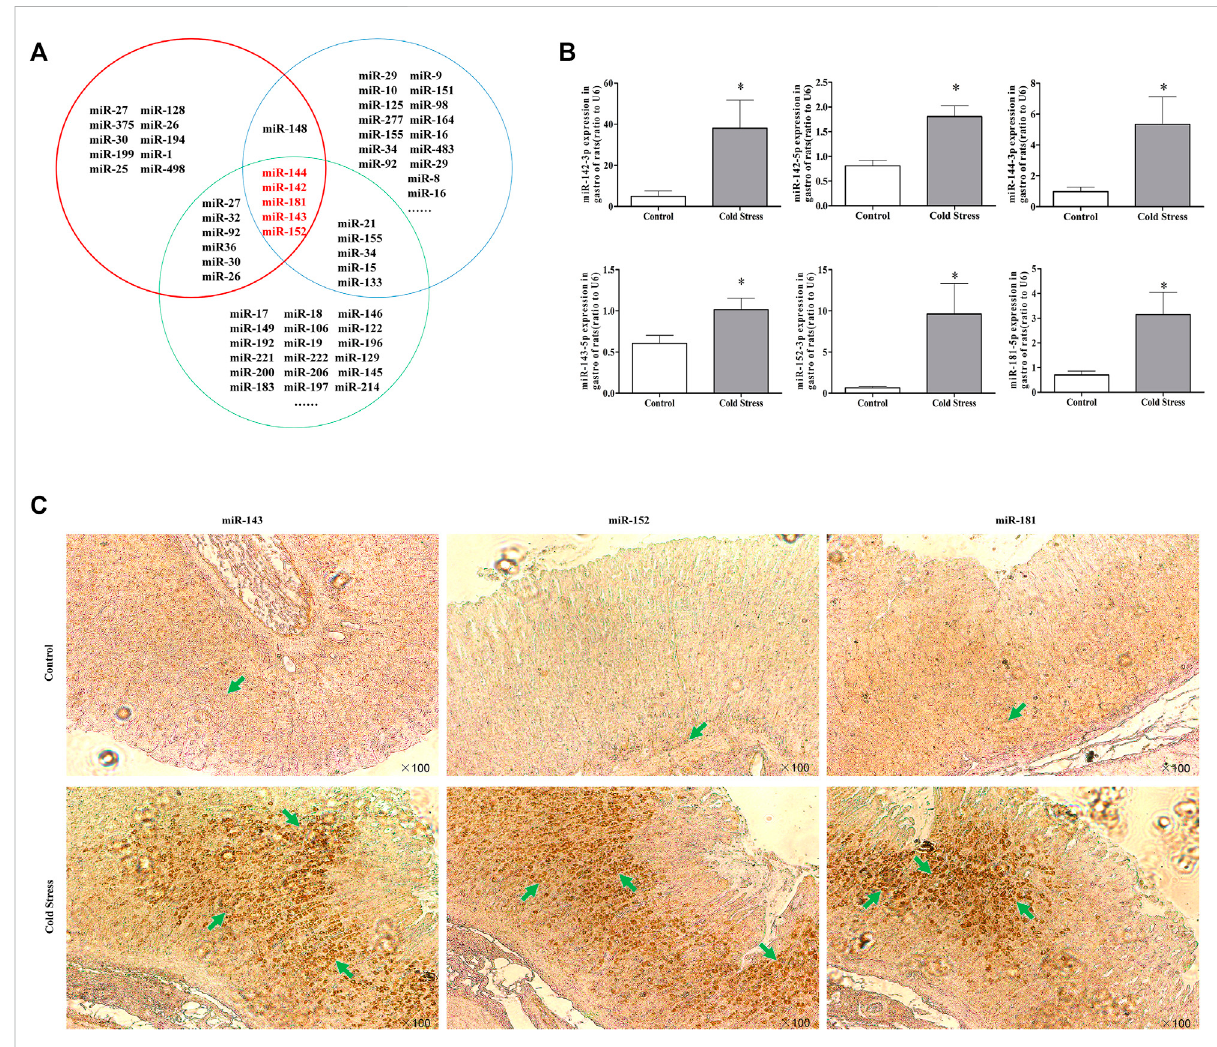
FIGURE 3 Change in miRNA expression in rats under cold stress. (A) Bioinformatics analysis of cold stress, apoptosis, and xCT-related miRNAs. The red circles represent xCT-related miRNAs; thegreen circles represent cold stress-relatedmiRNAs; theblue circles represent apoptosis-related miRNAs. (B) Changes in miRNA expression in gastric tissues during cold stress. Data are expressed as mean ± standard error ( n = 8). * p < 0.05 vs Control. (C) Effect of cold stress on miRNA expression in gastric tissues (100 in situ hybridization